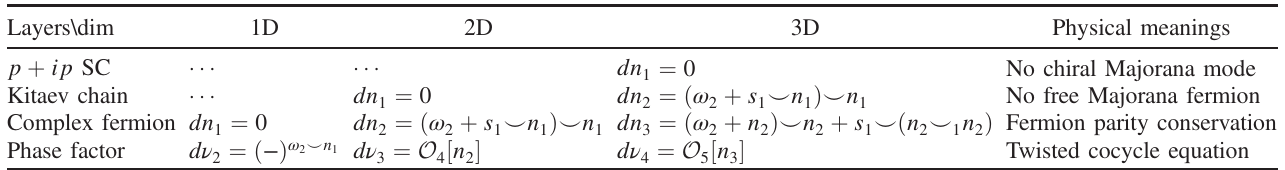
TABLE II. Consistency equations and their physical meanings for each layers. The physical meanings of the twisted equations (of the O O form dn or d ν ) are given in the last column of the table. The explicit expressions of O 4 ½ n 2 (cid:2) and O 5 ½ n 3 (cid:2) are given in i ¼ i þ 1 i ¼ i þ 1 Eqs. (136) and (220),